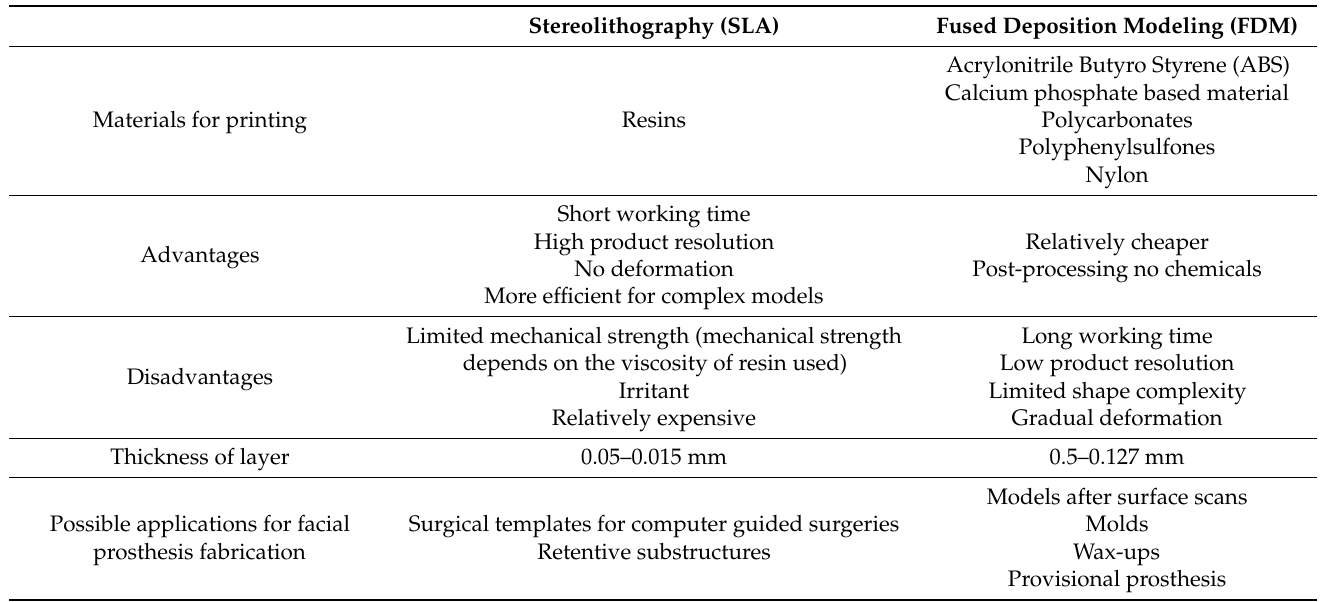
Table 4. Comparison between stereolithography (SLA) and fused deposition modeling and their applications (FDM) [17,51–55]. Stereolithography (SLA) Fused Deposition Modeling (FDM)